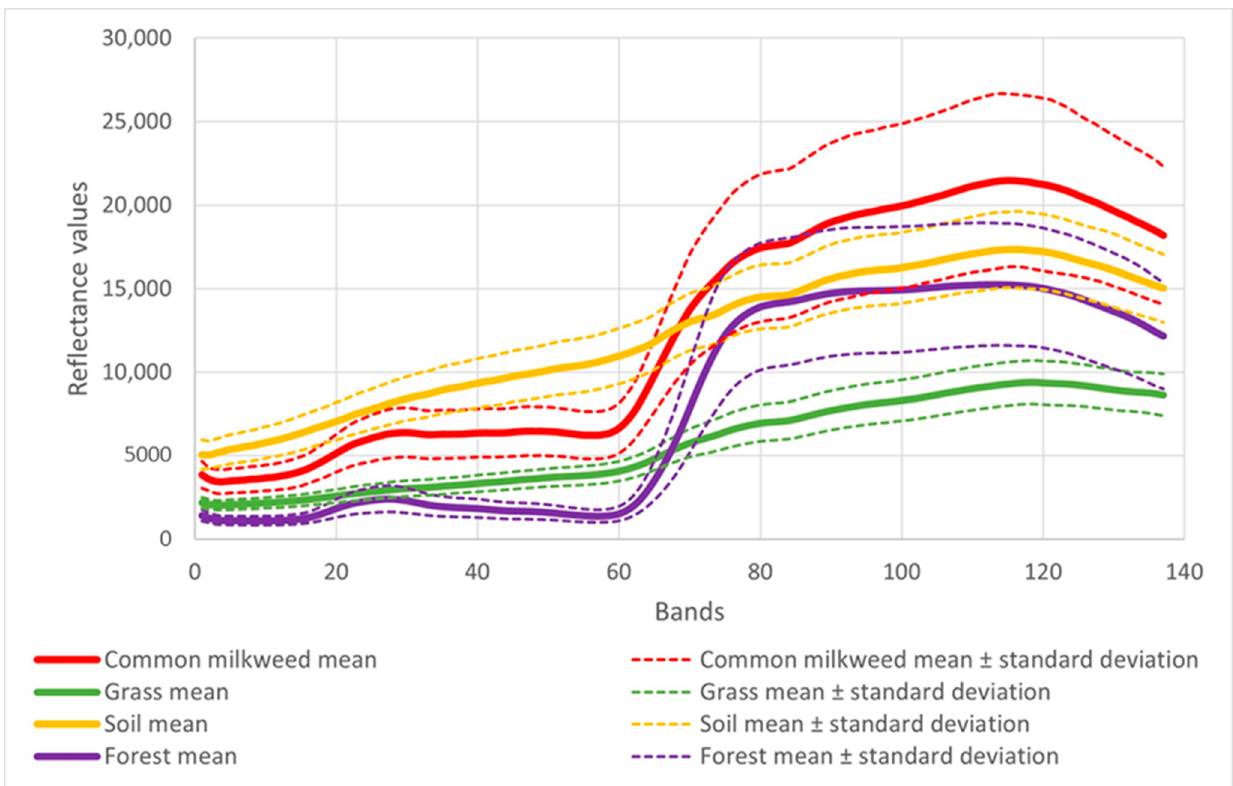
Figure 8. Mean reflectance values and standard deviation of principal classes present in the test field, derived from the hyperspectral data set.